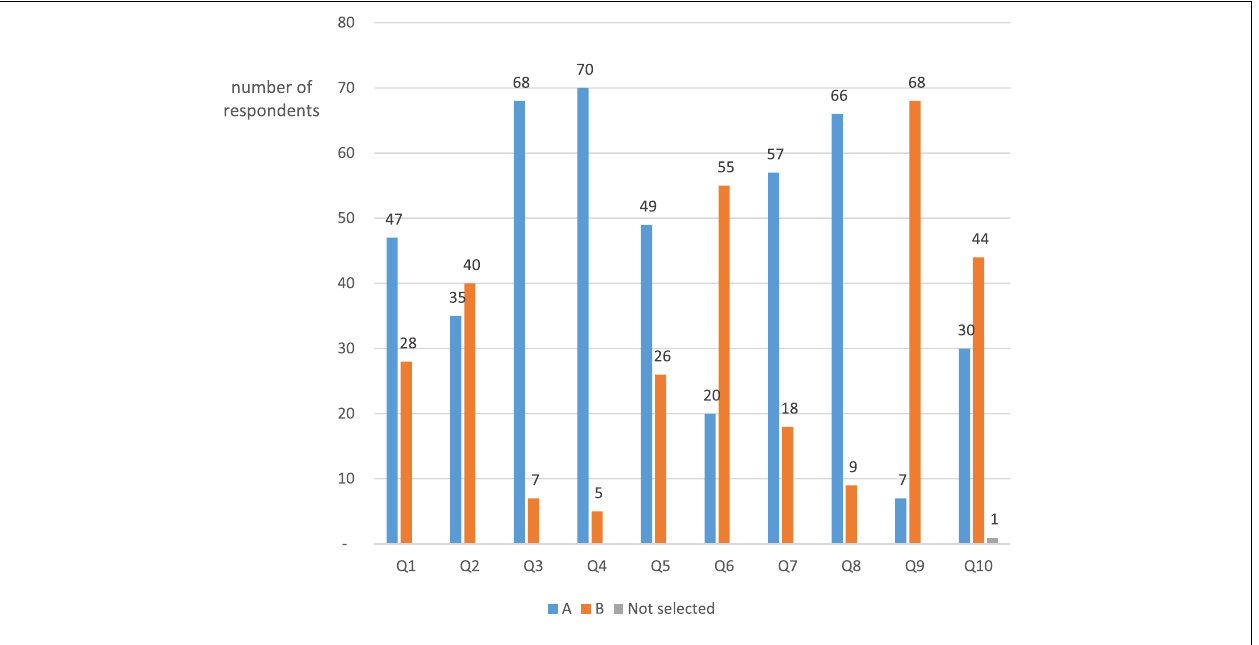
FIGURE 1 | Data statistics of self-test questions in the